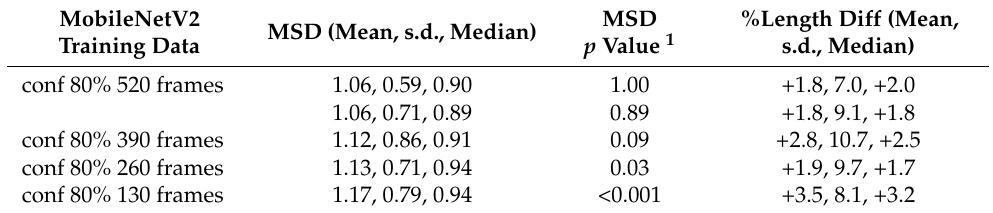
Table 3. Error scores vs. hand contoured for 20, 15, 10, and 5 frames per recording used for training.